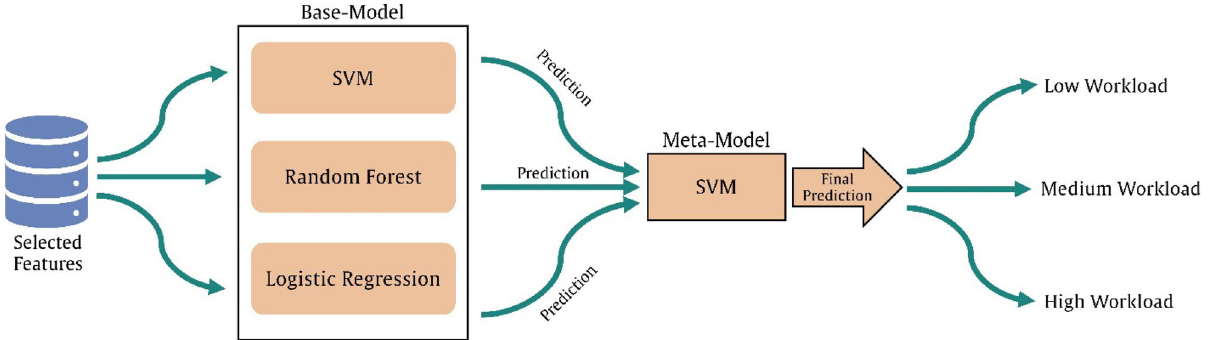
Figure 3. The architecture of the stacking ML